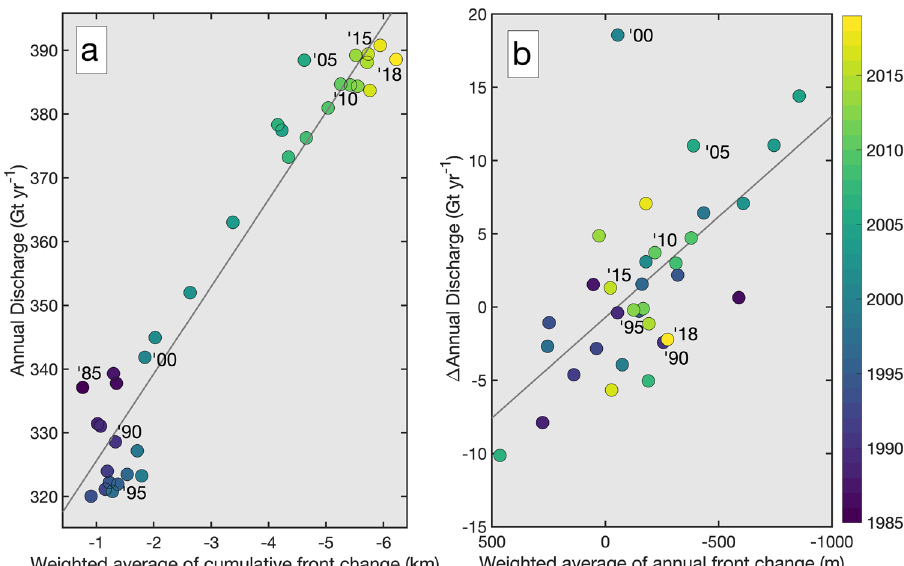
Fig. 2 GrIS-wide relationships between discharge and front position. a Annual total D versus net front position change for the 128 glaciers with continuous measurements between 1985 and 2018, with the color scale and label corresponding to the measurement year. The black line is the least- squares best fi t with a slope of 14 Gt yr − 1 per km of retreat and intercept of 312 Gt yr − 1 . Negative front change indicates net retreat from the glacier fronts ’ initial position over the calendar year. Note the reversed x -axis to highlight the inverse relationship. b Annual changes in D and front position with labels indicating the fi rst year (e.g., ‘ 00 is the change from 1999 to 2000). The (black line) least-squares fi t has a slope of 14 Gt yr − 1 per km of annual retreat and intercept of − 0.7 Gt yr − 1